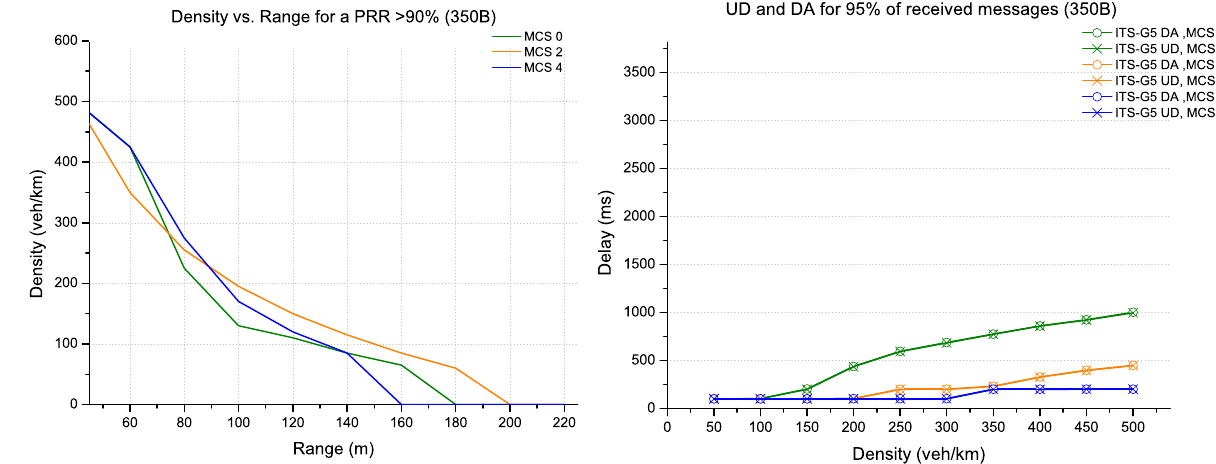
Figure 4. Evaluation for ITS-G5 technology (packet size 350